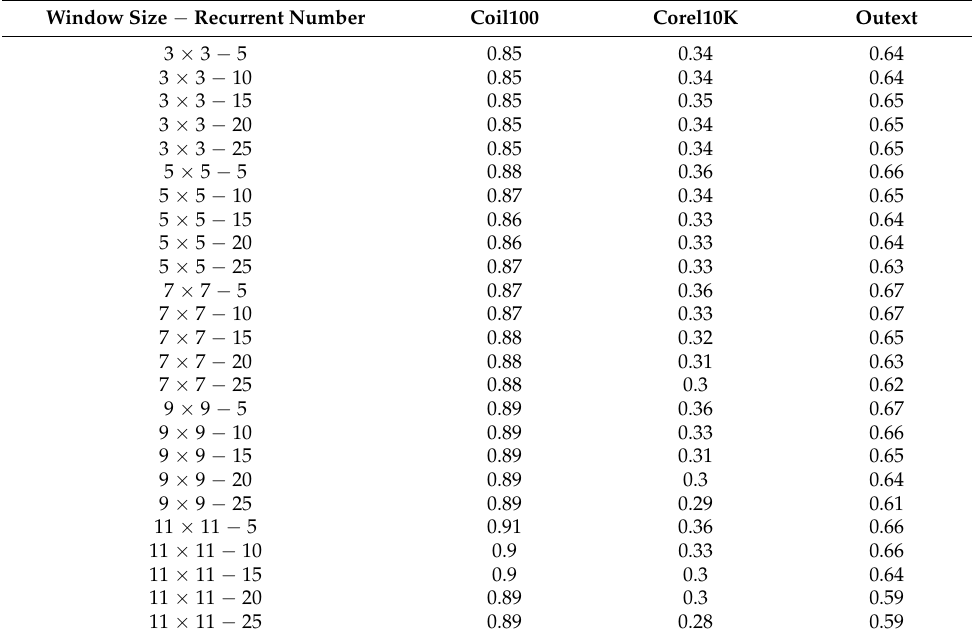
Table 1. Accuracy outputs for various window sizes and transformations for the three datasets using DC.